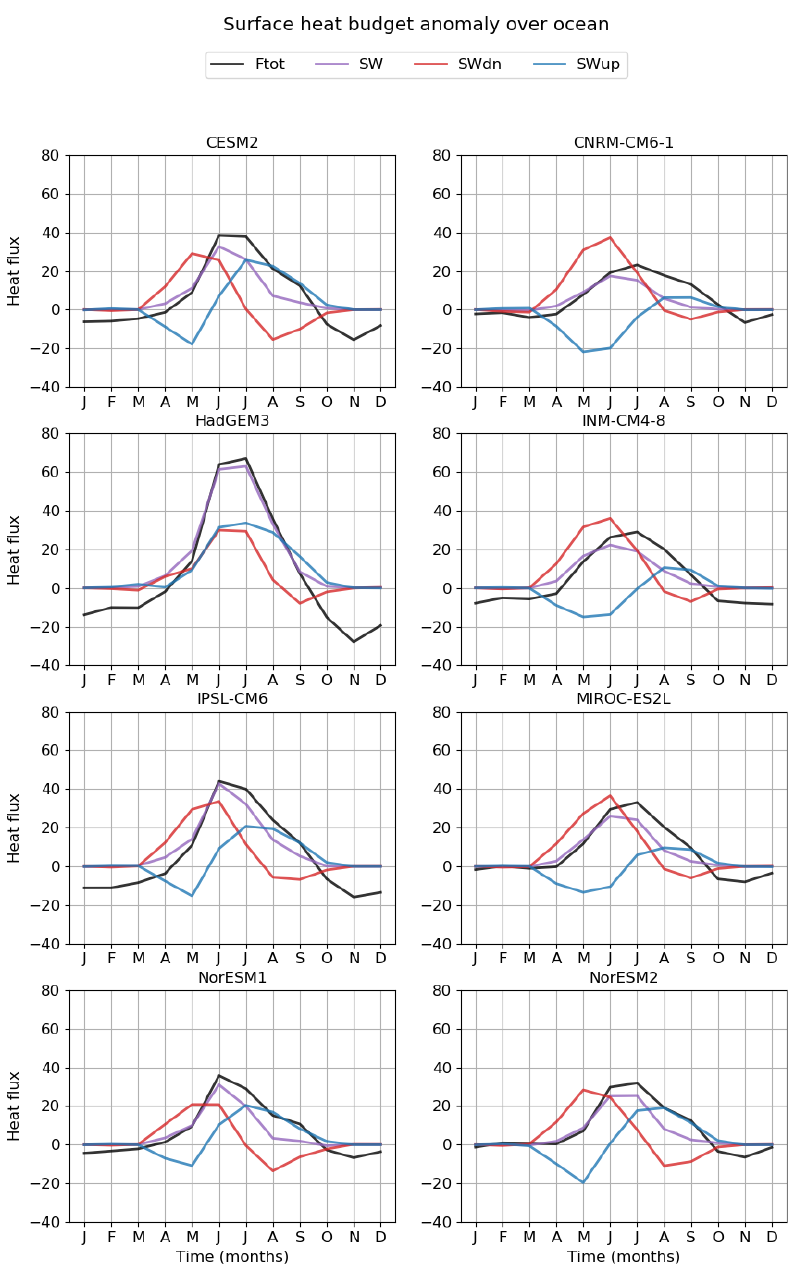
Figure 10. The main components of the atmospheric energy budget averaged over the Arctic (70–90 ◦ N) for HadGEM3, CESM2, CNRM- CM6-1, IPSLCM6, INM-CM4-8, MIROC-ES2L, NorESM1 and NorESM2. The LIG–PI anomalies are shown as a function of the month for the total energy budget (black), the SW budget (violet), and for the downward (red) and upward SW (blue) fluxes. The sign convention for all fluxes is the same as for Fig.